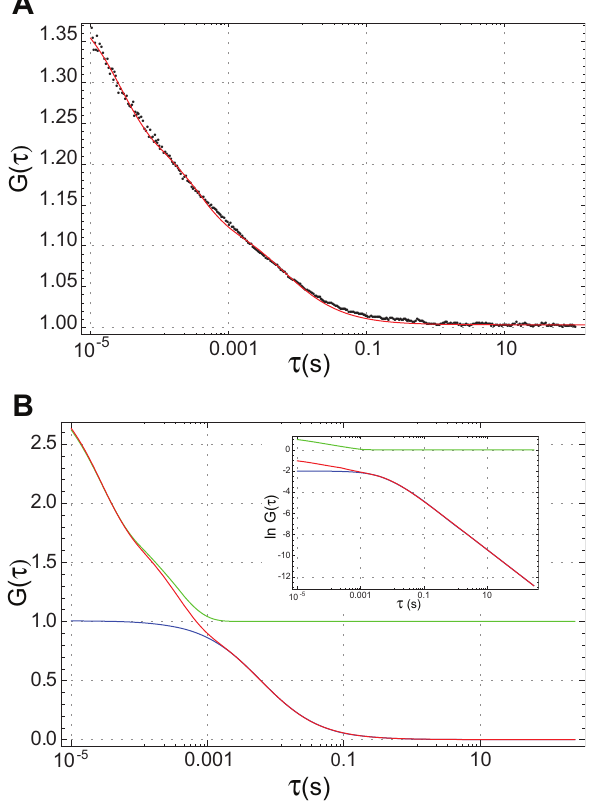
Figure 3. FCS autocorrelation curves. (A) A typical FCS autocor- relation curve G ( t ) for TetA-YFP in the strain DGC103 (black dots), along with the fitted theoretical curve (red line). This curve yields D =6.4 m m 2 / s. (B) The diffusion and fast dynamics terms in the fitting function for G ( t ) (see Methods) plotted separately to illustrate how they contribute. The red curve is the entire model G ( t ), identical to the curve in (A). The blue curve is G D ( t ) + B , the diffusion contribution. The green curve is G T ( t )/N + B , the fast dynamics contribution. (B, inset) Logarithms of the contributions to G ( t ) with the background B subtracted: ln( G ( t )- B ) (red), ln( G D ( t )) (blue), ln( G T ( t )) (green). The three curves satisfy ln( G ( t )- B ) = ln( G D ( t )) + ln( G T ( t )).